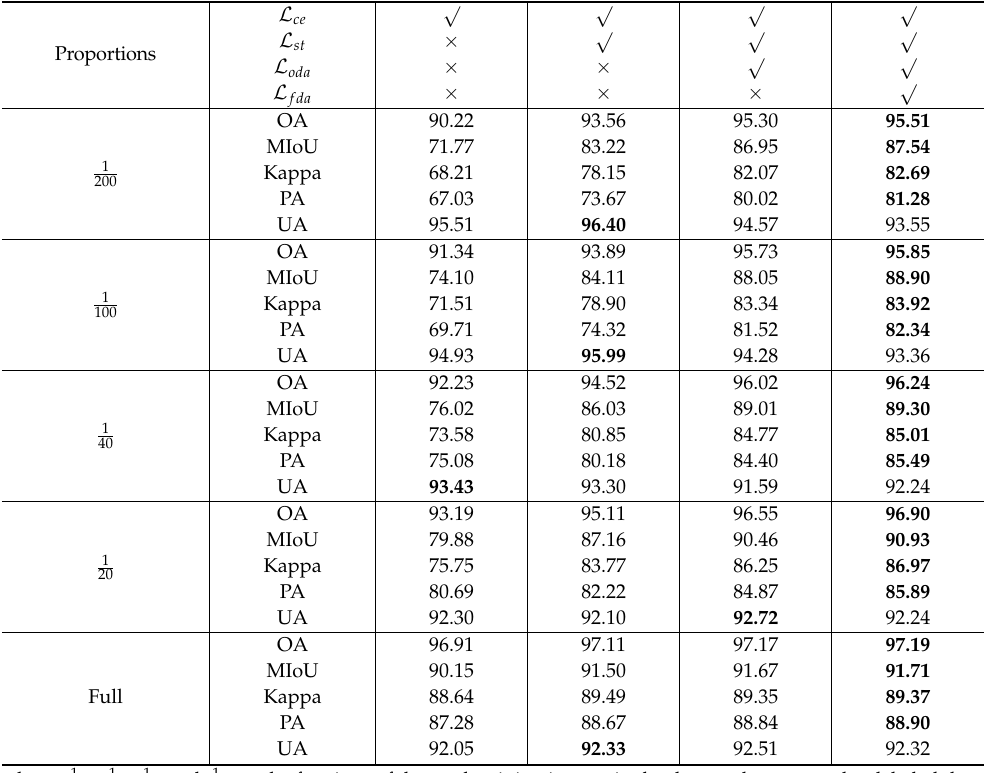
Table 2. Cloud extraction accuracy (%) of different ablation networks on GF-1 WFV data. L Proportions